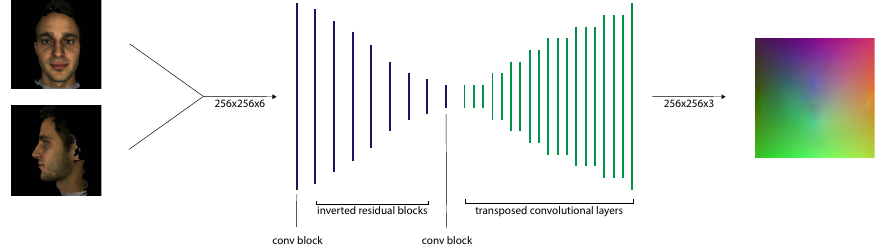
Figure 10. Our proposed 2-input CNN architecture for 3D face reconstruction. Input and Output